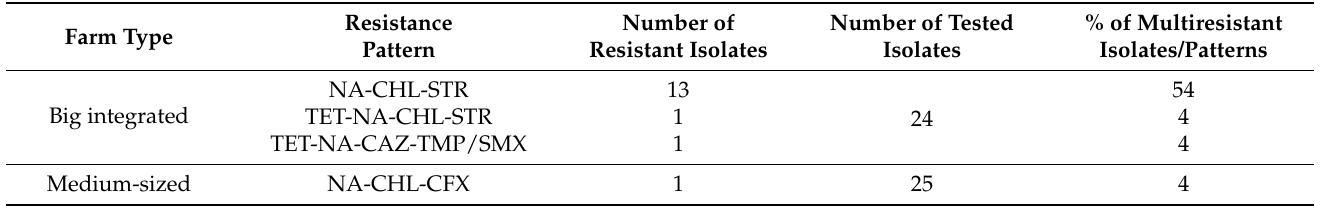
Table 5. Prevalence and resistance patterns of multiresistant Y. enterocolitica 4/O:3 in pig tonsils from different farm types (2014).